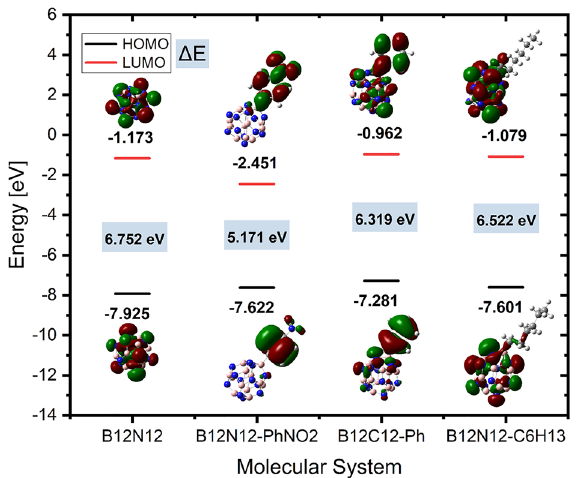
Figure 5. HOMO, LUMO and band gap of the bare and grafted B 12 N 12 nanocage